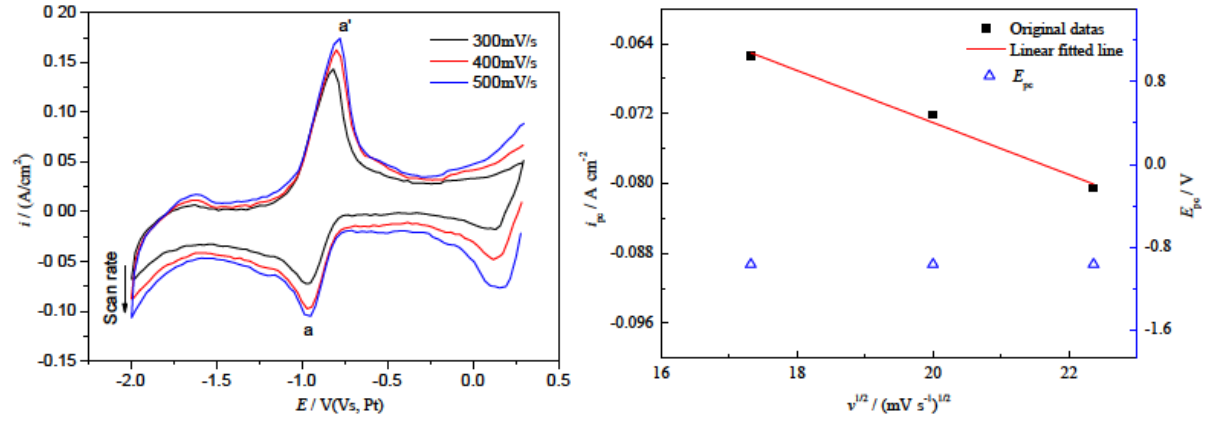
Figure 5: Cyclic voltammetry curve of NaCl-KCl-Na-ZrO 2 at different scanning speeds (a) Cyclic voltammetry curve (b) i pc ~ v 1/2 & E pc ~ v 1/2 (rate scan: 300-500mV/s, vs. Pt)